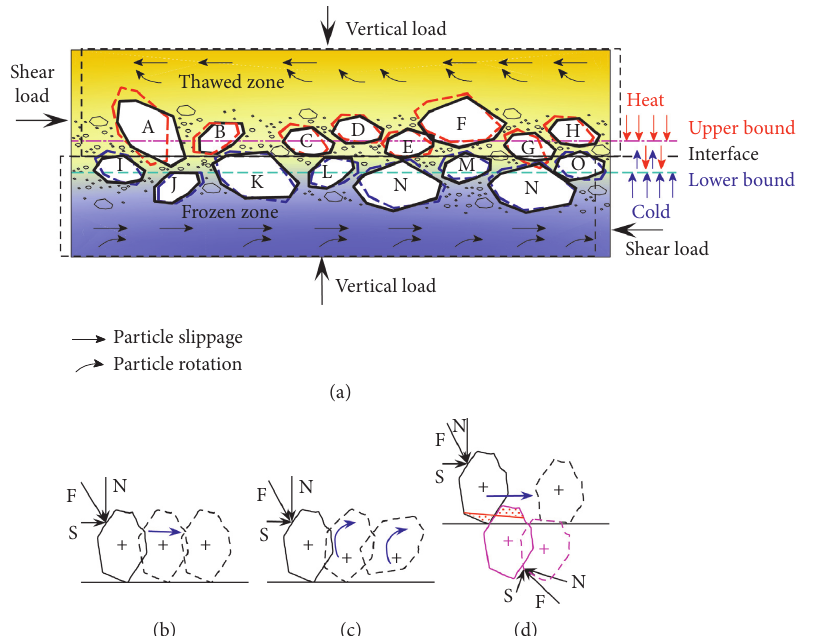
Figure 13: Particle movement in freeze-thaw interface during the shearing process. (a) Shear process. (b) Particle slippage. (c) Particle rotation. (d) Particle